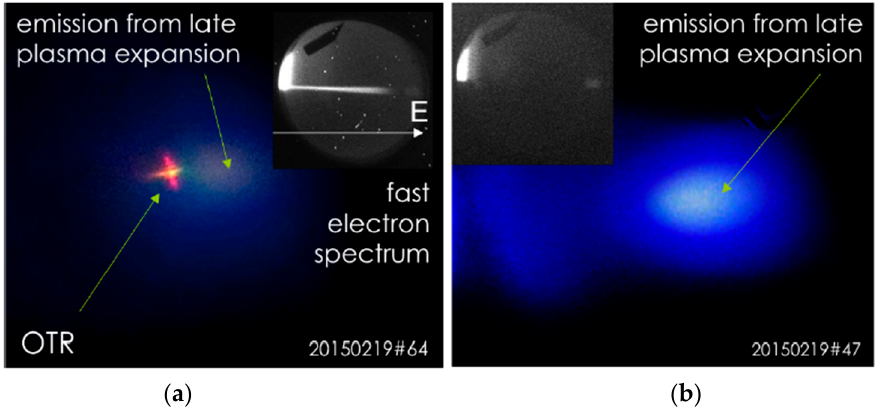
Figure 5. ( a ) Rear side optical imaging showing Optical Transition Radiation from fast electrons from laser irradiation of 10- μ m thick Al foil at the best focus position. The insert shows the raw spectrum of fast electrons obtained with a permanent magnet spectrometer. ( b ) Same image, but with the target displaced by two Rayleigh lengths (100 μ m).